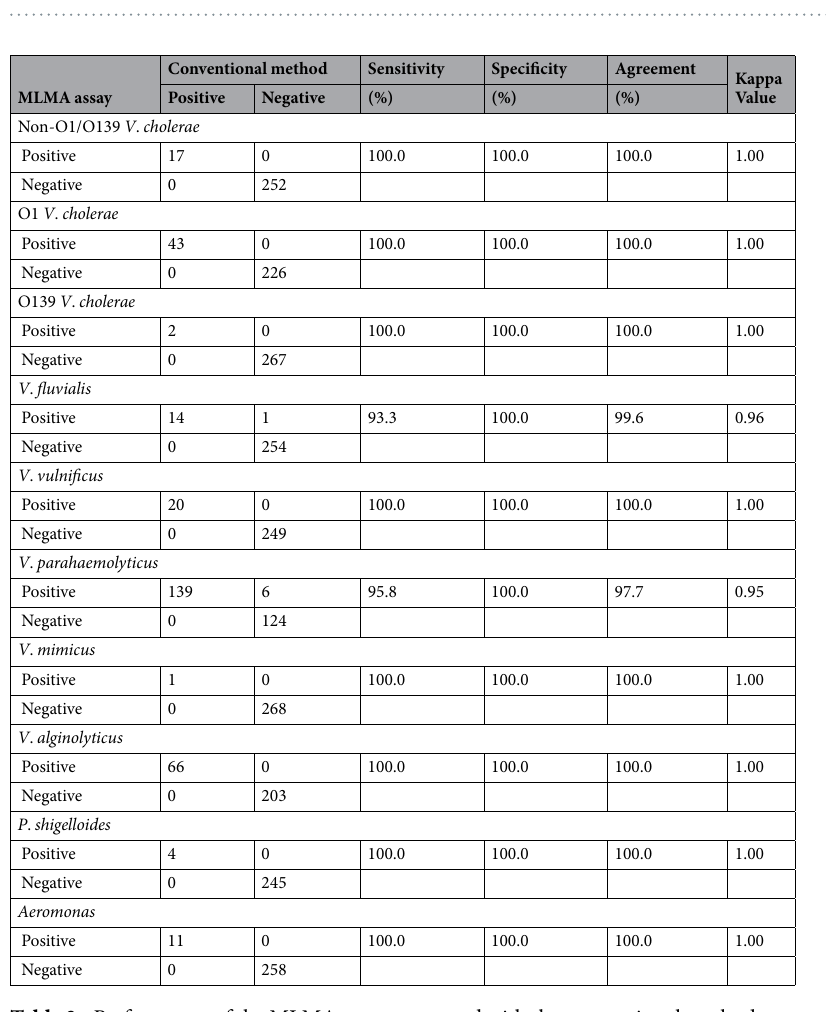
Figure 3. Specificity of the MLMA assay in detecting reference strains from different sources.